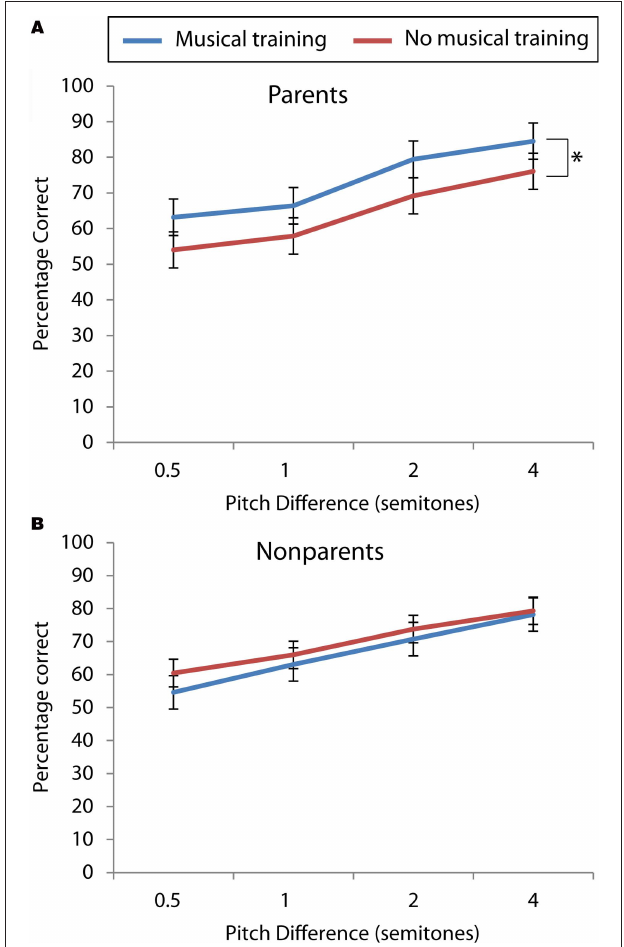
FIGURE 1 | Percentage of correct trials at each level of pitch difference for (A) parents and (B) non-parents, comparing adults with and without music training. The scores of parents with music training were significantly higher than the scores of parents without music training, but for non-parents, there was no difference. * significant difference.